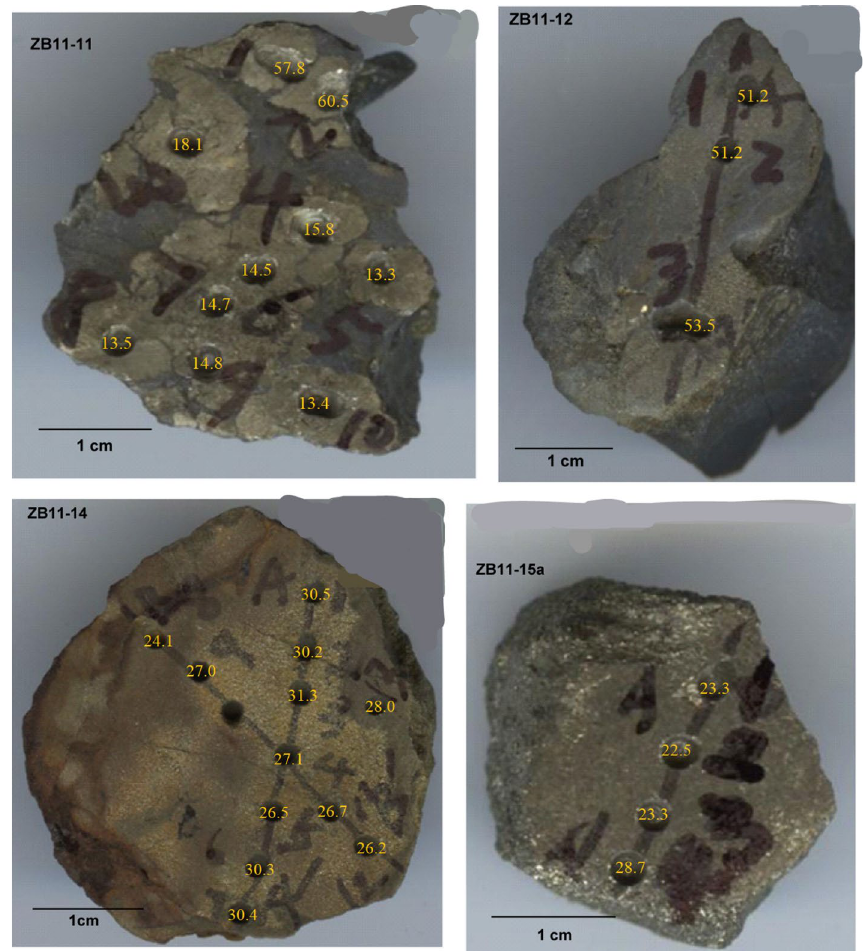
Figure 3. Millimeter-resolution sampling of pyrite nodules with their δ 34 S values displayed.